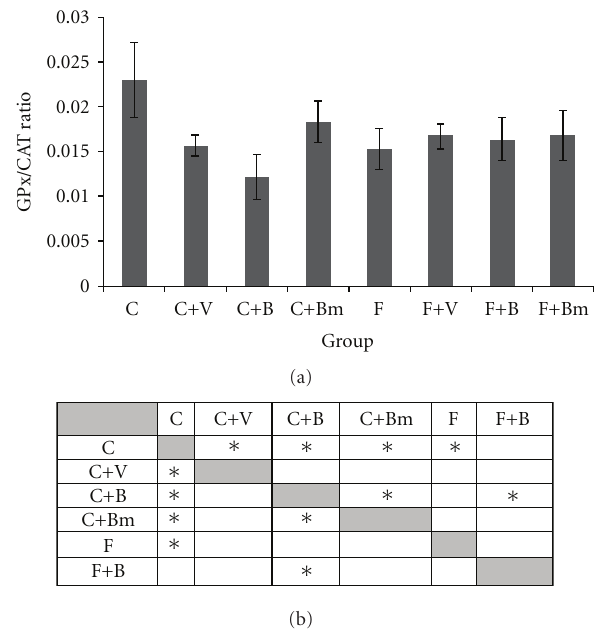
Figure 9: E ff ects of vanadium complex V, B, and Bm on plasma GPx/CAT ratio of Wistar rats. Data are presented as mean ± SD for n = 6. (b) Statistical di ff erences between groups P <